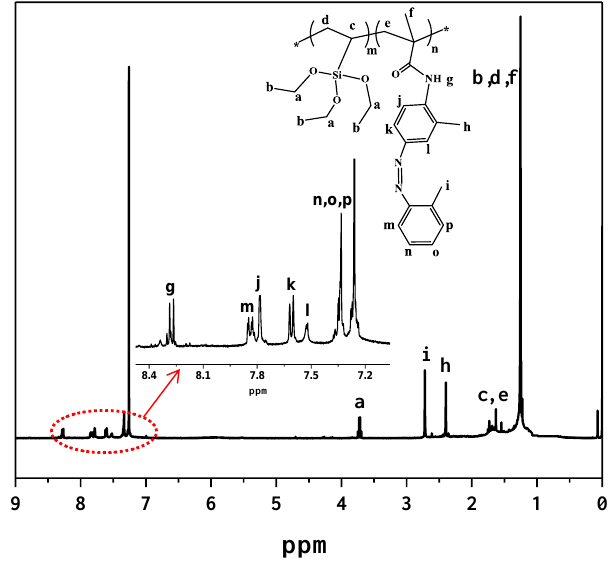
Figure 1. 1 H NMR spectra of PFMV.